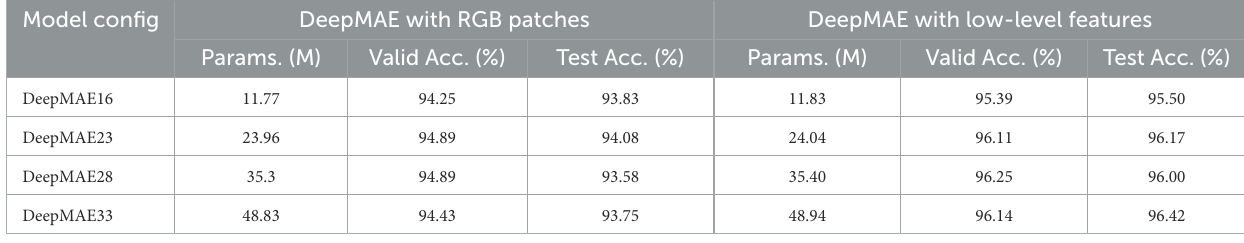
TABLE 3 Comparison of RGB patches and low-level feature patches on four DEEPMAEs. Model config